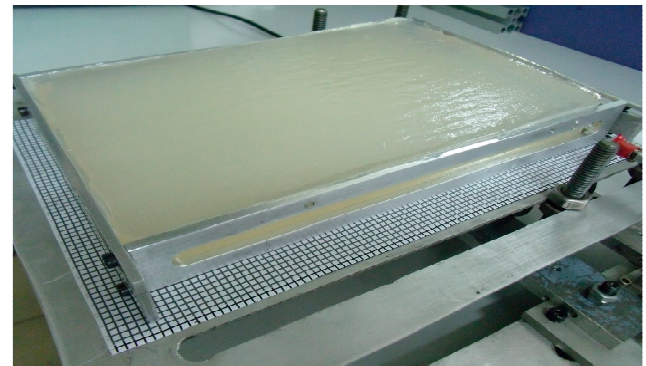
Figure 5. Artificial tissue.